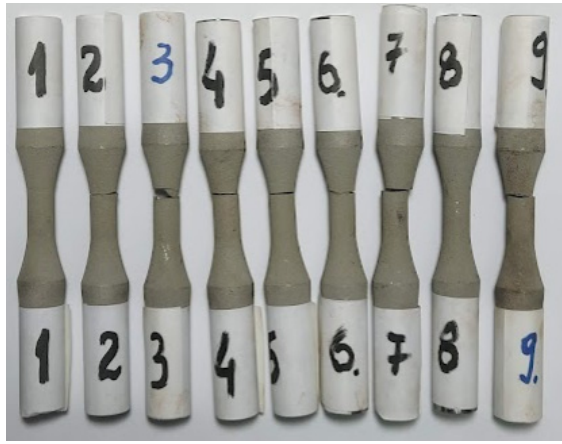
Figure 8. Samples after loading by alternate-symmetric fatigue tests. 3.1. Samples 1 and 8 ( σ max (MPa); N), (420; 5,519,600) and (438;